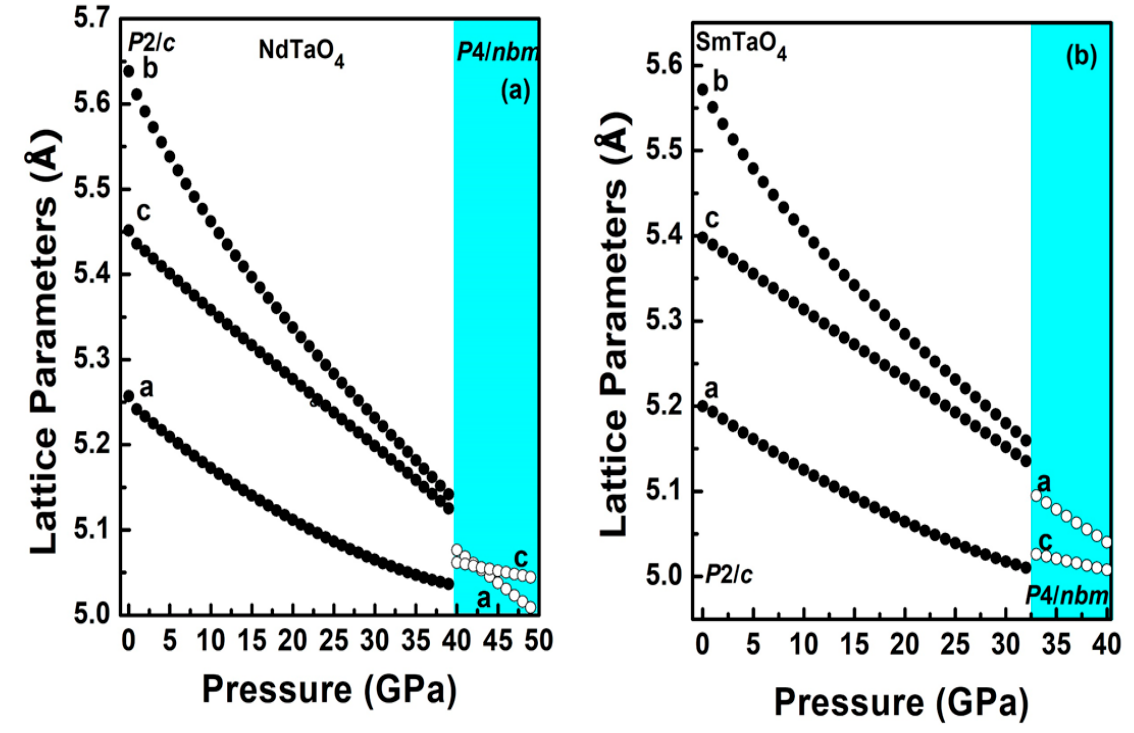
Figure 3. Pressure dependence of unit cell lattice parameters for the compounds ( a ) NdTaO 4 and ( b ) SmTaO 4 in the low-pressure phase (solid circle) and the high-pressure phase (empty circle). The colored region describes the high-pressure tetragonal phase.